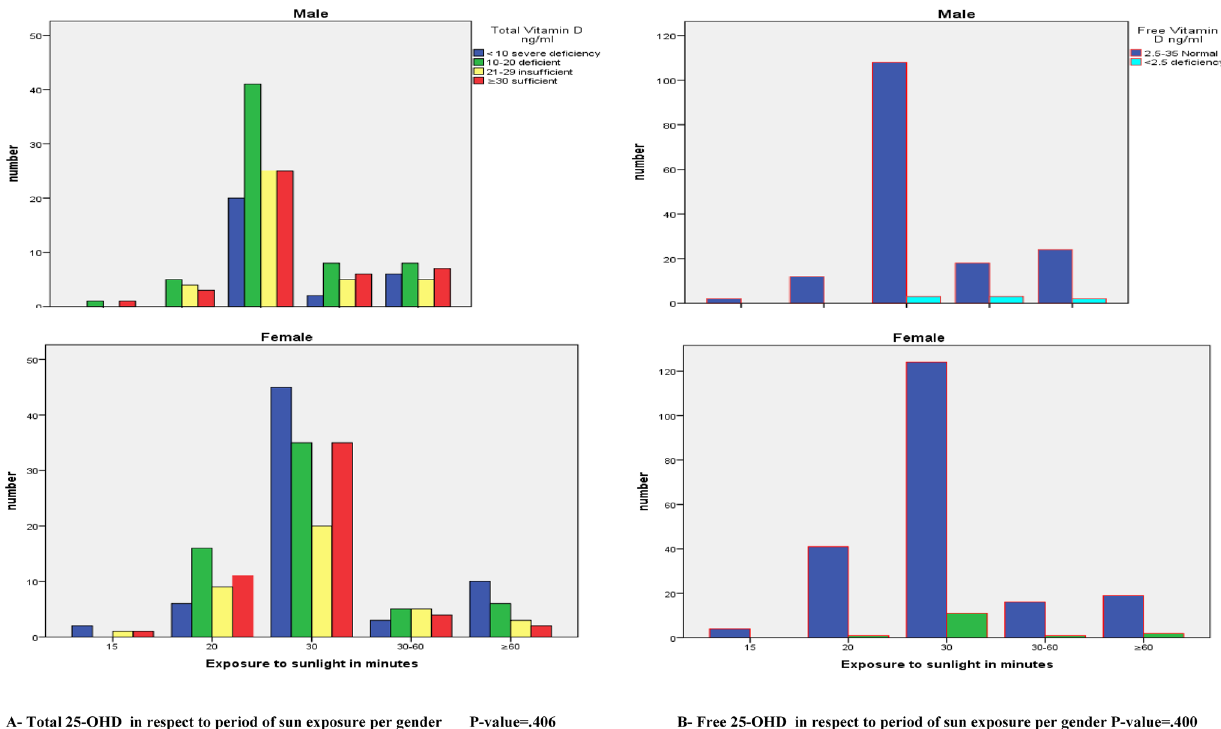
Figure 1. Total and Free 25-OHD in respect to period of sun exposure per gender. ( A ) Total 25-OHD in respect to period of sun exposure per gender P-value = 0.406. ( B ) Free 25-OHD in respect to period of sun exposure per gender P-value =